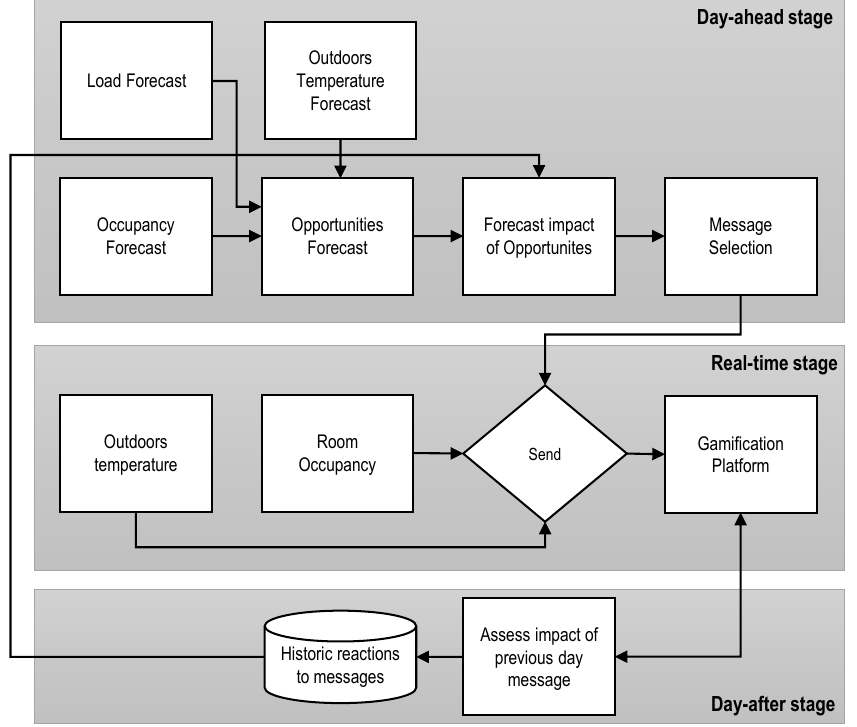
Figure 20. Behavior predictor